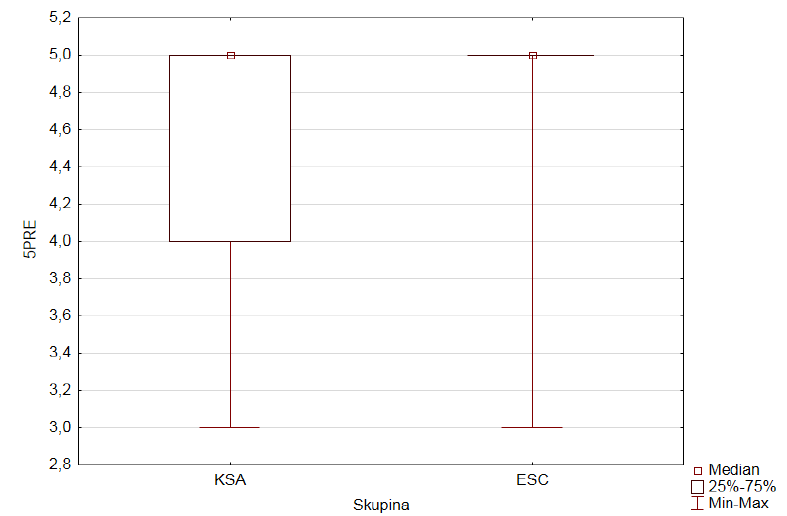
Figure 5. The box graph of the fifth item of the pretest - 5PRE.